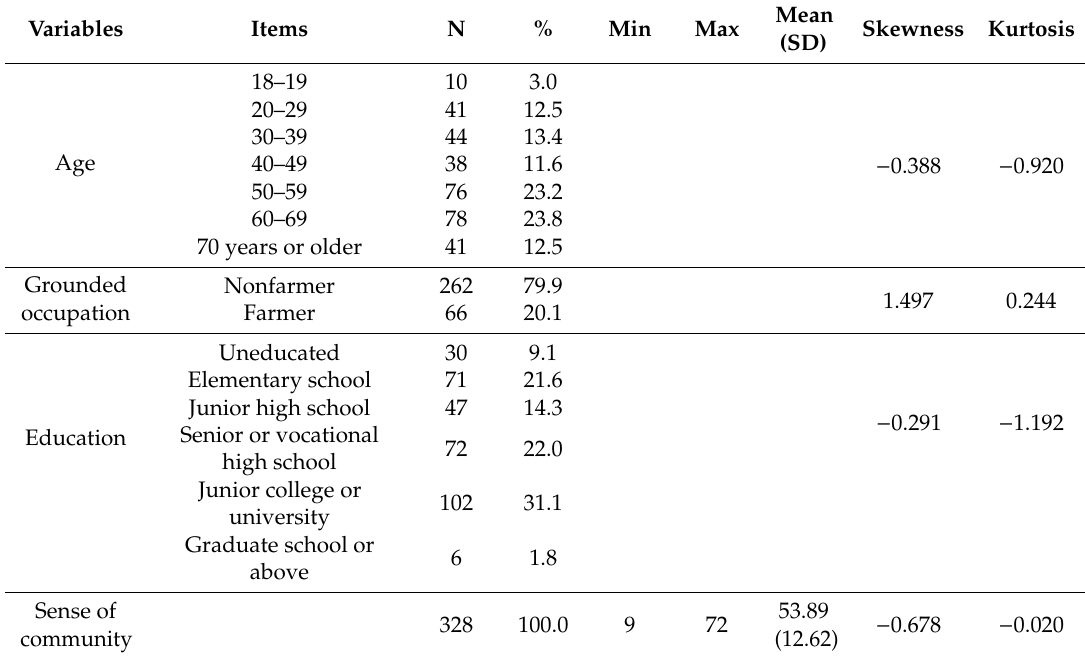
Table 2. Descriptive